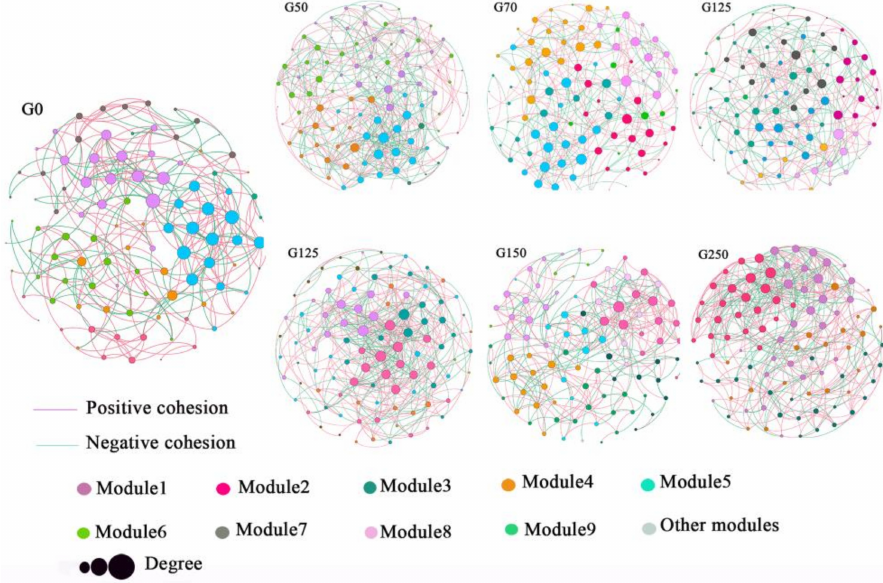
Figure 4. The co-occurrence networks of soil bacterial modularity in different-sized forest